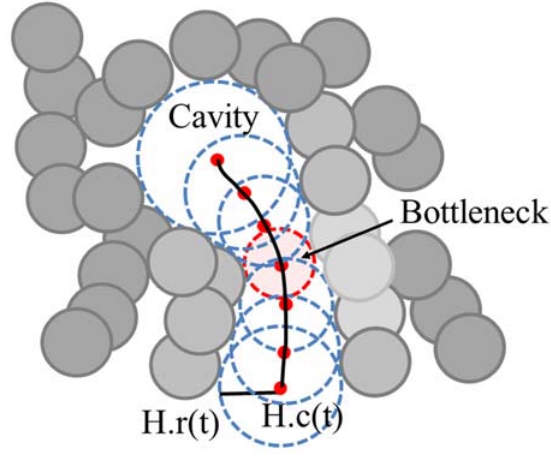
Figure 2. Example of the tunnel in the protein molecule and its bottleneck.